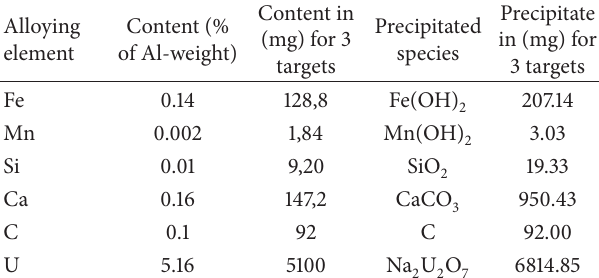
Table 1: Composition of the target material and the related compo- sition of the precipitate after the dissolving